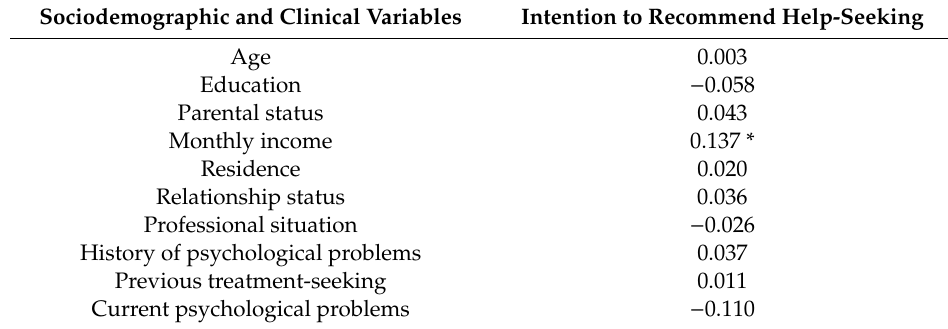
Table 2. Pearson’s correlation between the intention to recommend professional help-seeking to a partner with mood and anxiety disorders in the postpartum period and the sociodemographic and clinical